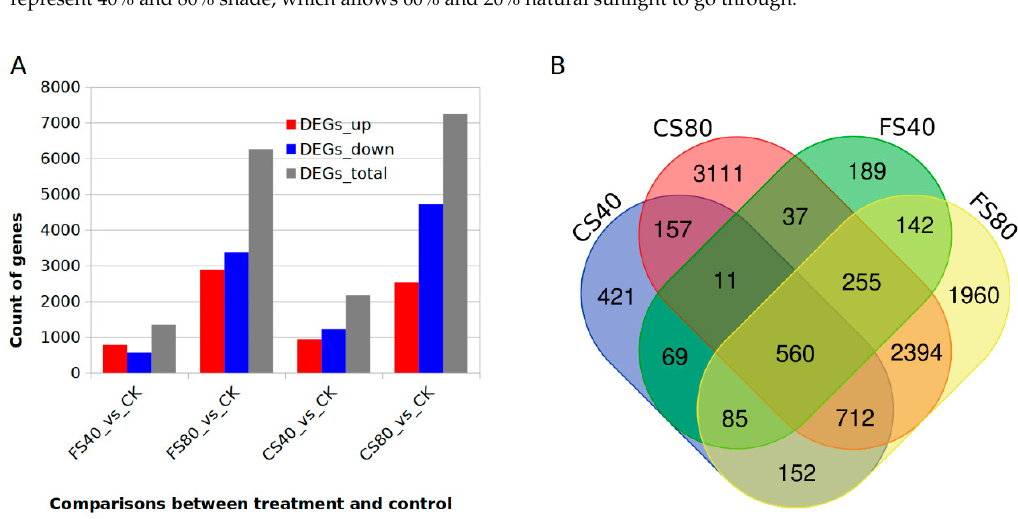
Figure 3. Comparison of DEGs induced by different shade stresses in peanut plants. ( A ). The number of up-, down- and total- regulated differentially expressed genes (DEGs) induced by different shading treatments compared with control (CK) under natural sunlight in peanut plants. ( B ). Venn graph showing the common and specific DEGs across samples after shade treatments. FS40, FS80, CS40, and CS80 represent shade treatments of 40% shade at flowering stage for 30 days, 80% shade at flowering stage for 30 days, 40% shade from seeding stage for 30 days to flowering stage for another 30 days, 80% shade from seeding stage for 30 days to flowering stage for another 30 days, respectively. Three experiments were conducted, each with three plants.